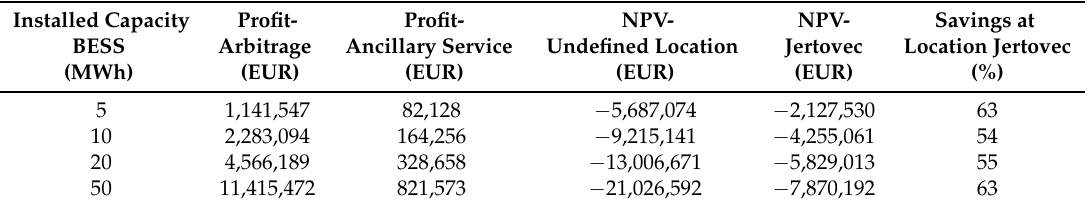
Table 3. Profit-20 years ( G 20 ): arbitrage and ancillary services; NPV values: undefined location and location Jertovec.